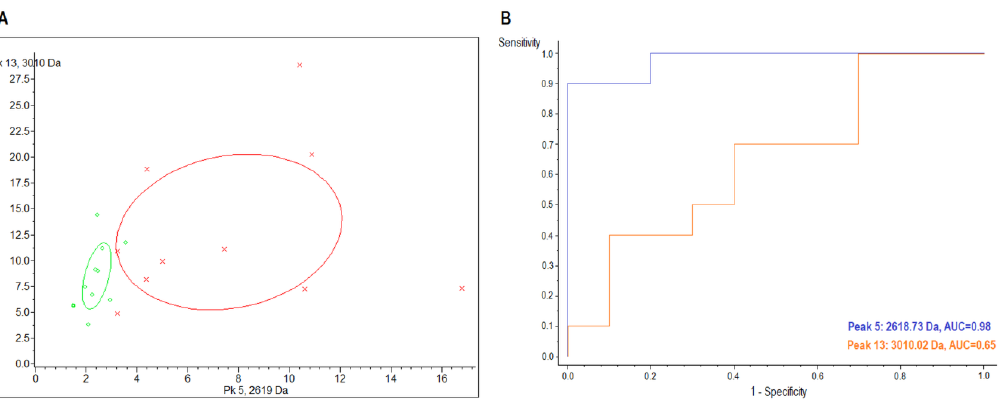
Figure 2. ( A ) Scatter plot of the urine samples determined by the combination of peptide/protein, with m / z 2618.7 (x-axis) and 3010.0 (y-axis) (peaks with lowest p -values) between healthy control subjects (red) and CIN3 (green) patients. Confidence intervals of 95% are shown by ellipses. ( B ) ROC curve plots showing the correlation between the sensitivity and specificity of the m / z 2618.7 (blue) and 3010.0 (orange). Areas under the ROC curves (AUC) are 0.98 and 0.65, respectively. Table 2. Statistical analysis of the most discriminating protein or polypeptide ions in the cluster analysis by 2D peak distribution.